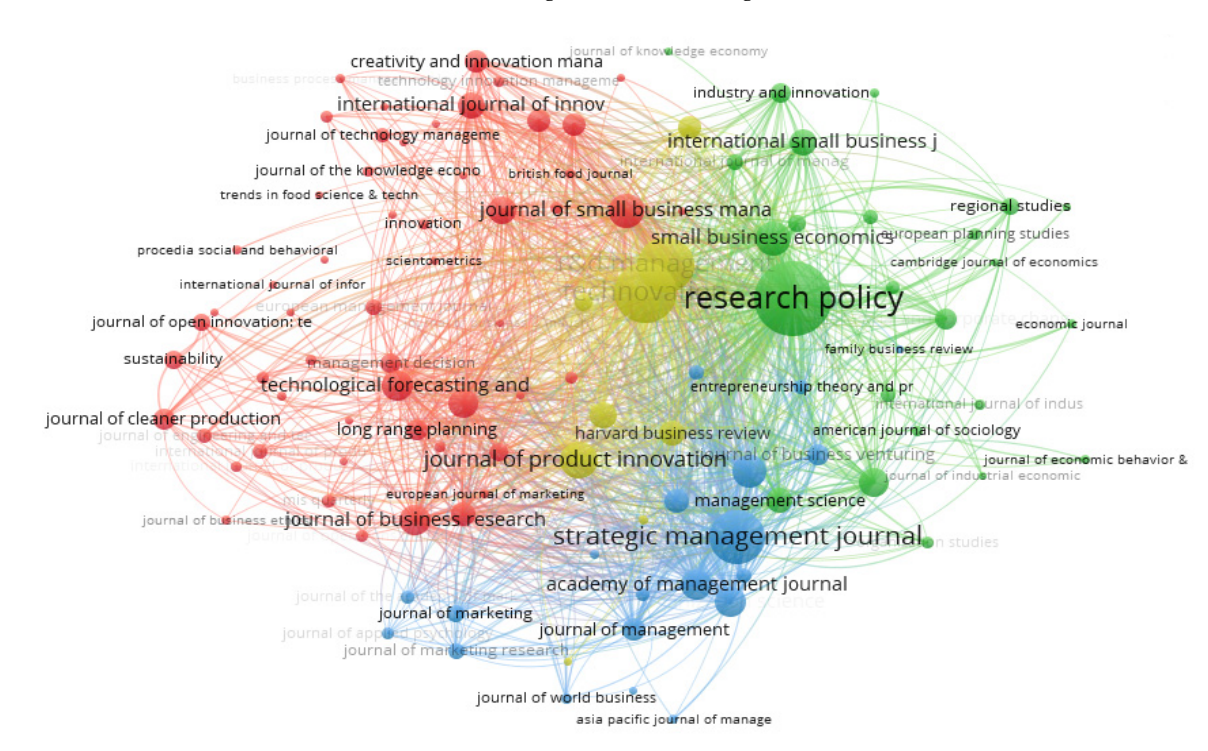
Figure 6. Visualization of journal co-citation network. Cluster 3 (blue colour), “ Business Research ”, consists of 20 journals with 3096